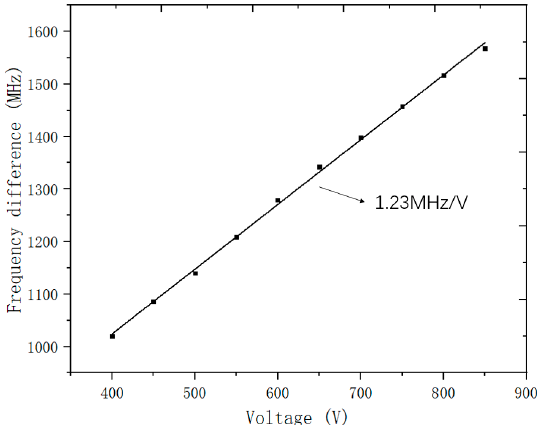
Figure 4. The relationship between the frequency difference and voltage when the temperature is constant.